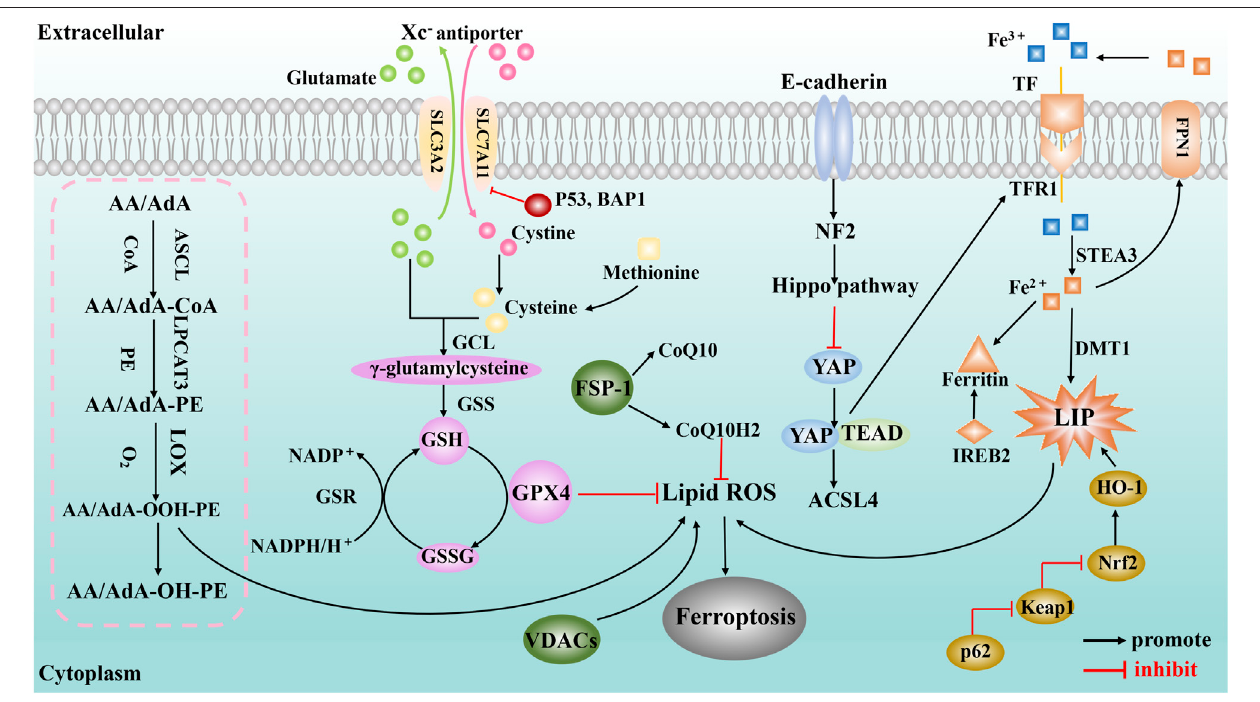
FIGURE1| Aschematicillustrationshowingthemainmechanismsofferroptosis.ThepurplespheresrepresentpathwayscenteredonGPX4(includingthesystem Xc − amino acid transport system, p53 regulation, BAP1 regulation and transsulfuration pathway); the pink dashed box represents the lipid metabolism pathway; the orangeshapesrepresentsignalingpathwayscenteredonironmetabolism(includingthegoldenovalsrepresentingthep62-Keap1-Nrf2regulatorypathwayandIREB2); and the green spheres represent the regulation of ferroptosis by mitochondria (VDACs) and ferroxidase inhibitory protein 1-coenzyme Q10 (FSP-1-CoQ10).